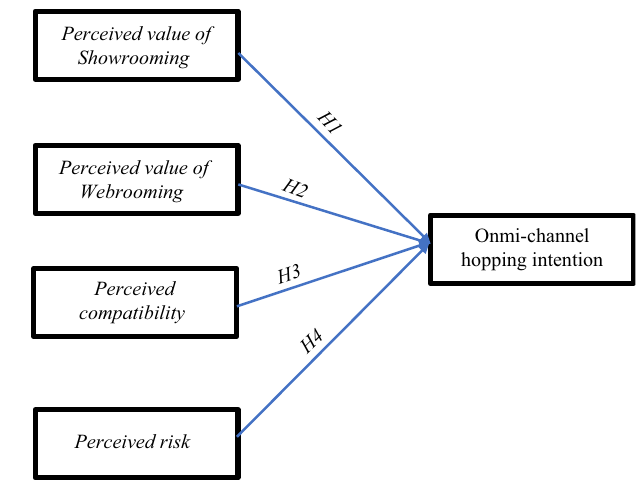
Figure 1. Proposed research